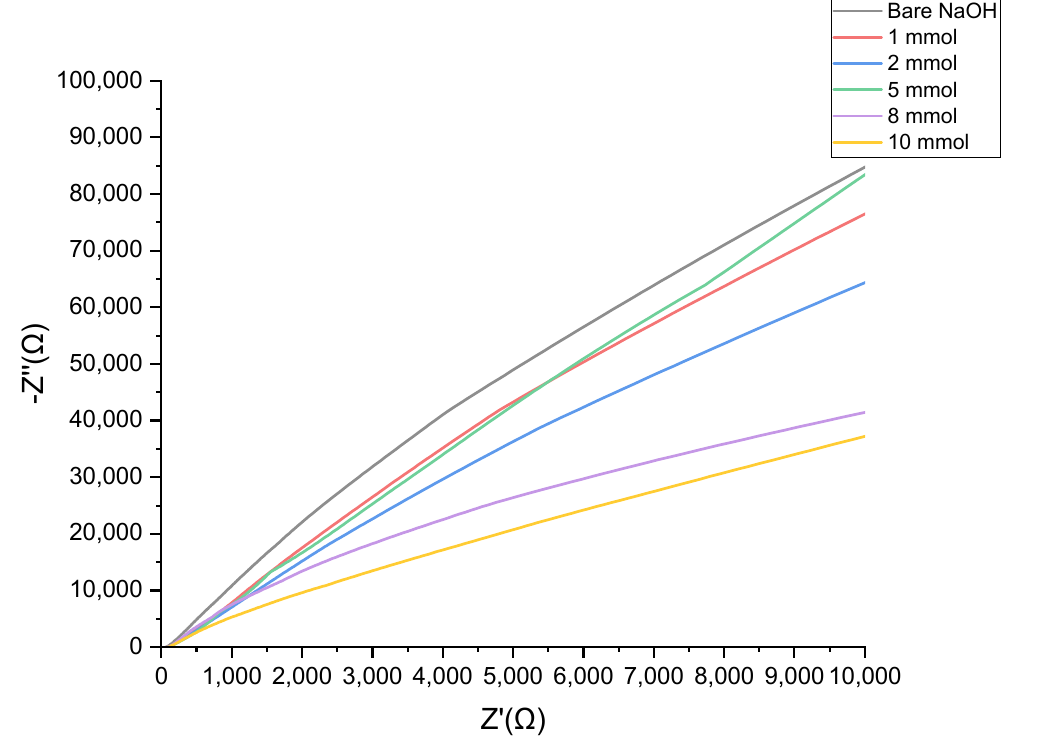
Figure 12. Nyquist plots for Au-Ni/AC SPE in 0.1 M NaOH solution for 0–10 mM glucose concentration range.